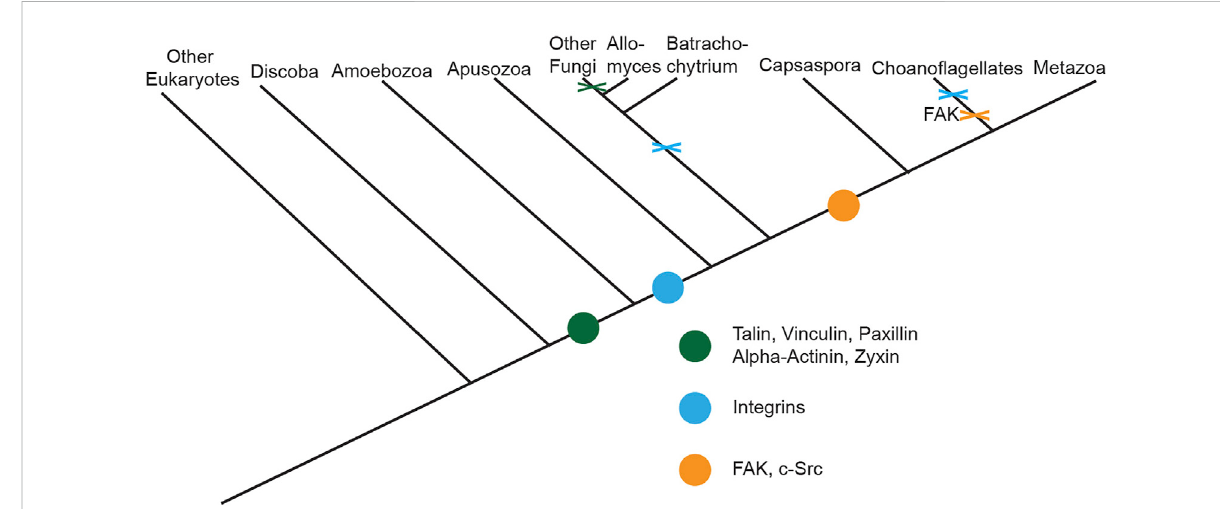
FIGURE 1 Evolution of cell-substrate adhesion machinery across Eukaryotes. Cladogram depicting the origin and lineage-speci fi c losses of known core components of Metazoan cell-substrate adhesion machinery across Eukaryotes. Origin of a component is indicated by a colored dot along the cladogramwhilelossofcomponentspriortothedivergenceofalineageisdenoted via